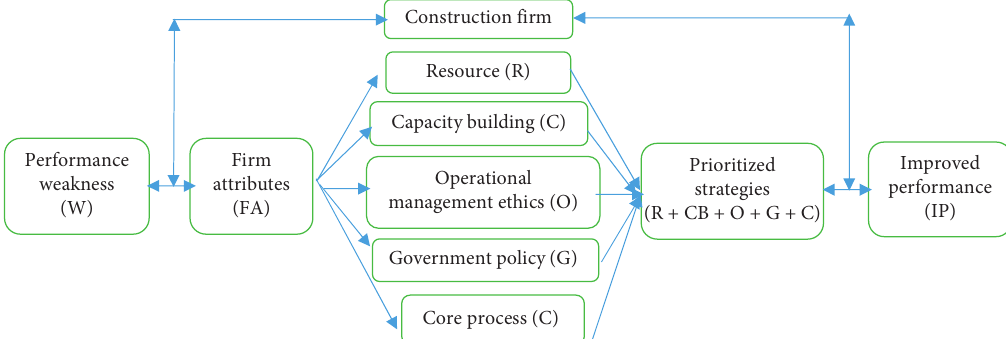
Figure 2: A conceptual framework of the